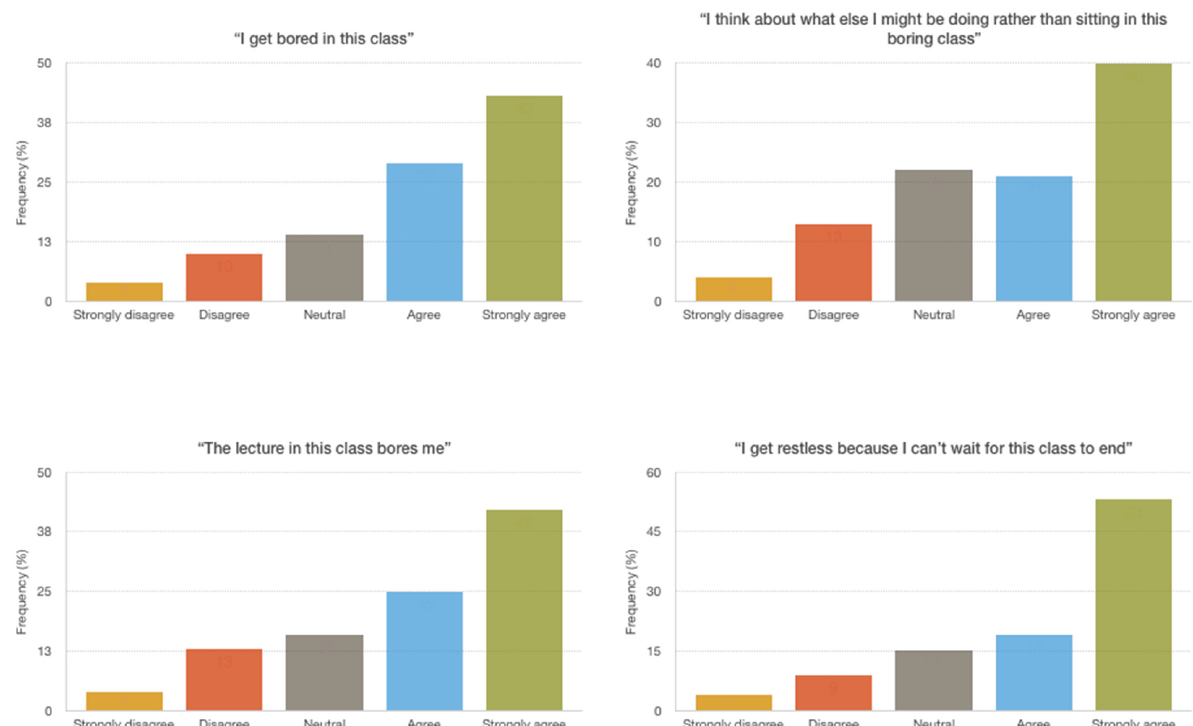
Figure 2. Student frequencies of reported classroom boredom at baseline. Note. Participants’ responses to classroom boredom items are displayed (prior to watching the psychoeducational boredom video).